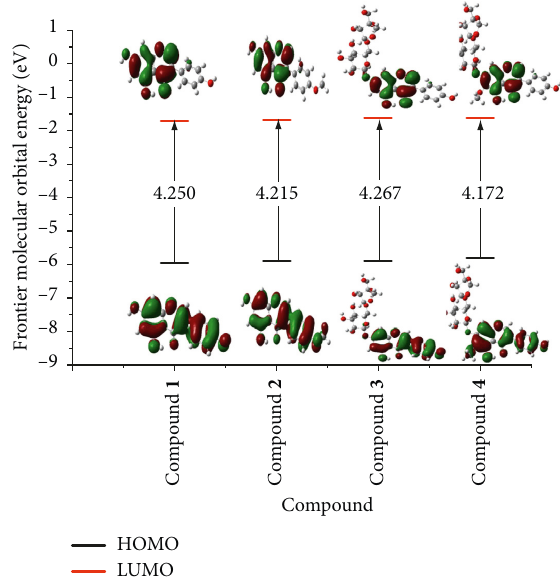
Figure 4: Neutral HOMO and LUMO images and E tures 1–4 in gas medium.